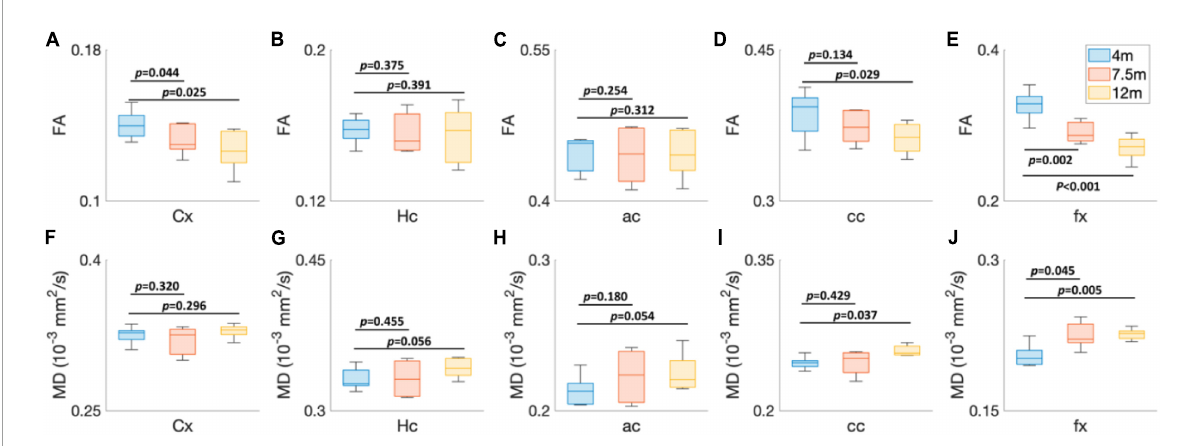
FIGURE4 The age-dependent (4, 7.5, and 12 months) FA (A–E) and MD (F–J) values of 5xFAD mice at different brain regions. Cx, cortex; Hc, hippocampus; ac, anterior commissure; cc, corpus callosum; fx, fornix.